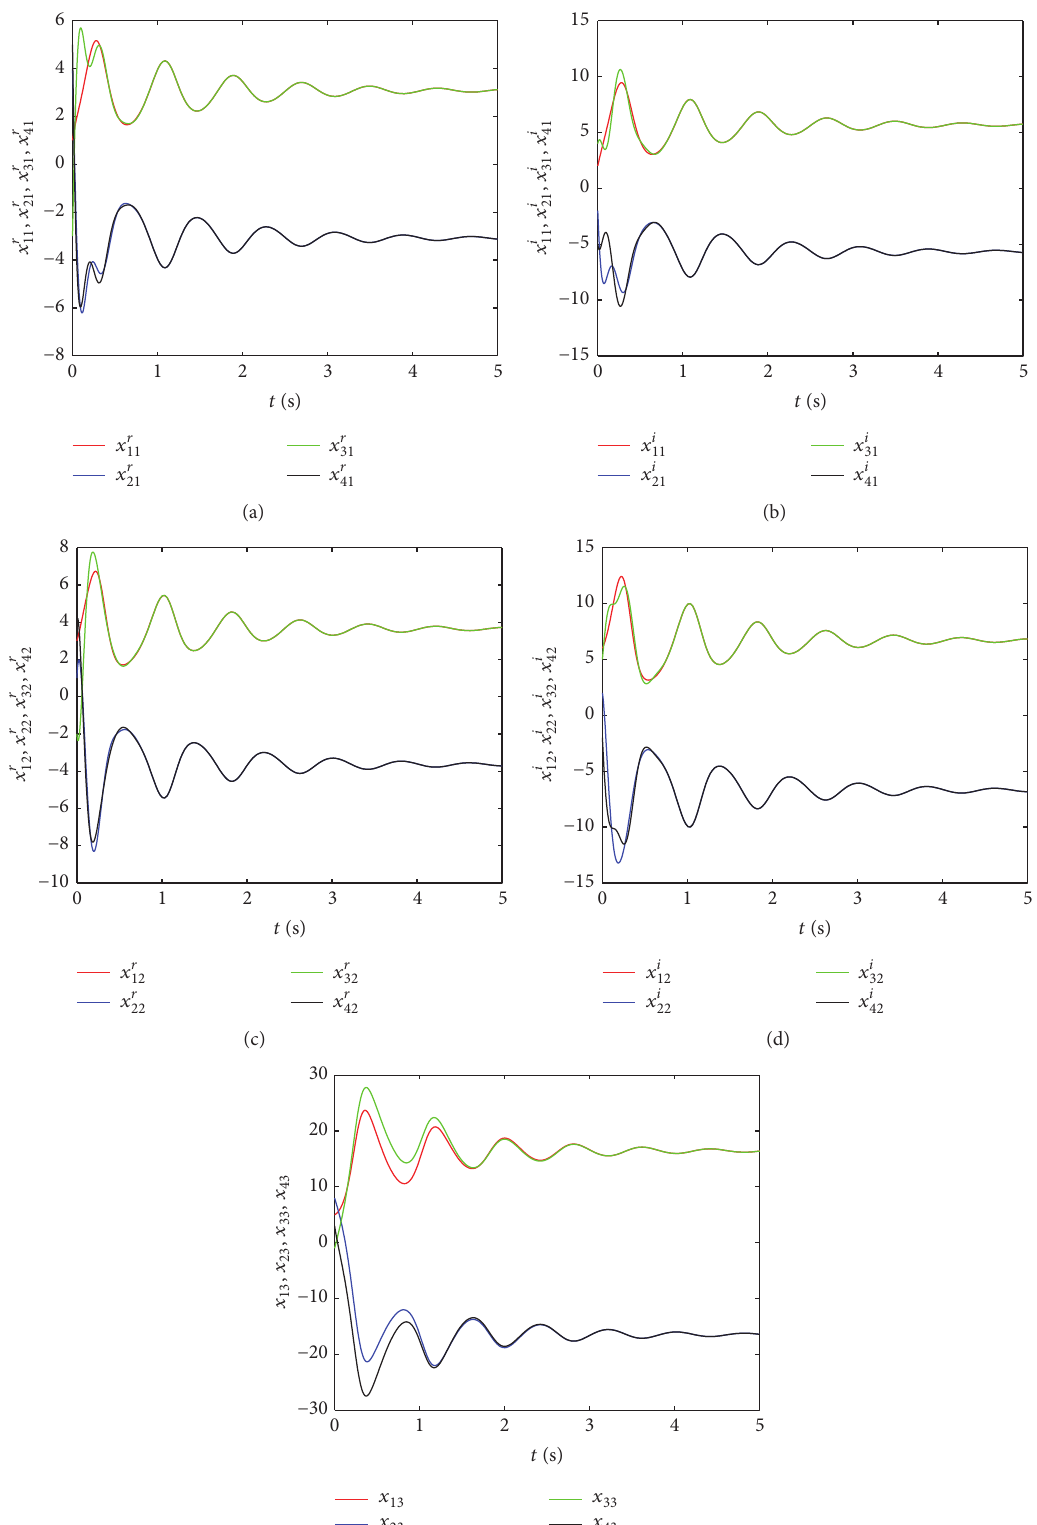
Figure 5: The state trajectories 𝑥 𝑘1 , 𝑥 𝑘2 , and 𝑥 𝑘3 ( 𝑘 = 1, 2, 3,4 ) for antisynchronization of 4 -coupled complex PMSM